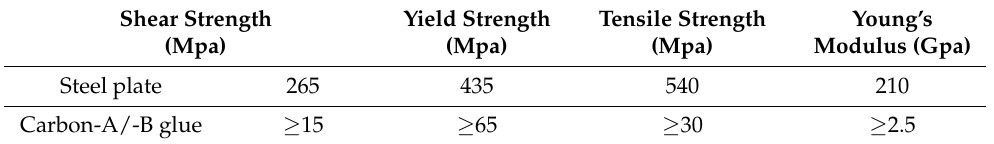
Figure 2. Carbon-A/-B glue and mixture. ( a ) Glue. ( b ) Mixture. Table 1. Material properties of carbon-A/-B glue and the steel